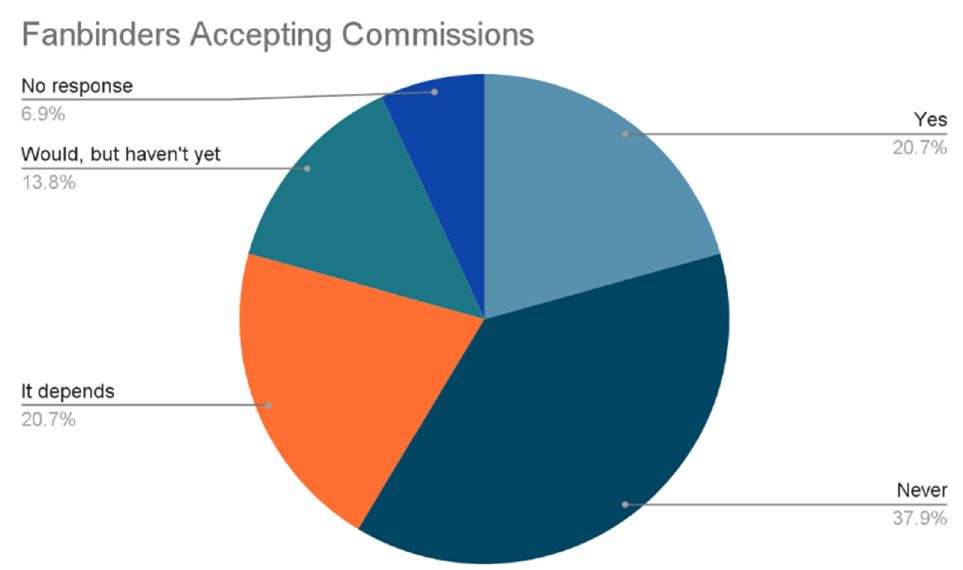
Figure 1. Fanbinders Accepting Commissions.